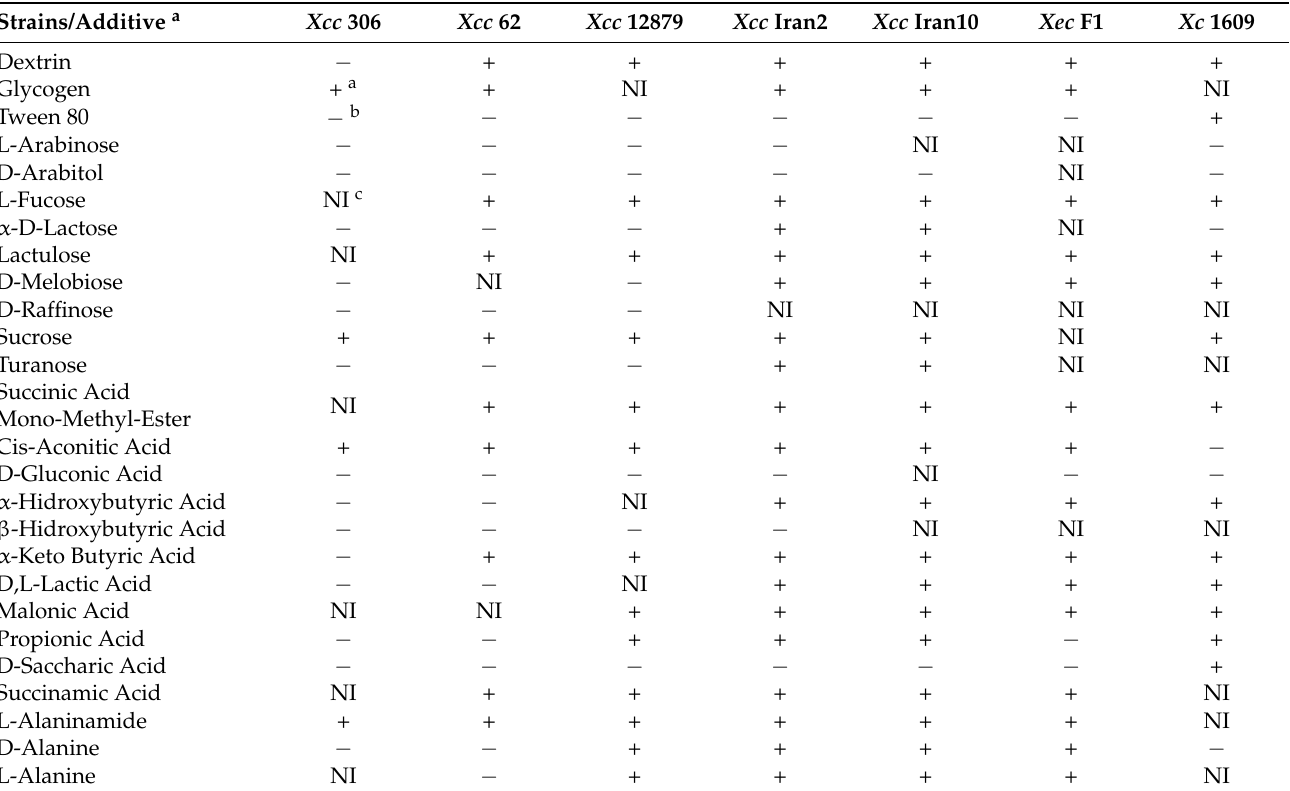
Table 3. Biolog activity of carbon sources that differentiates species and strains of Xanthomonas pathogenic for citrus and